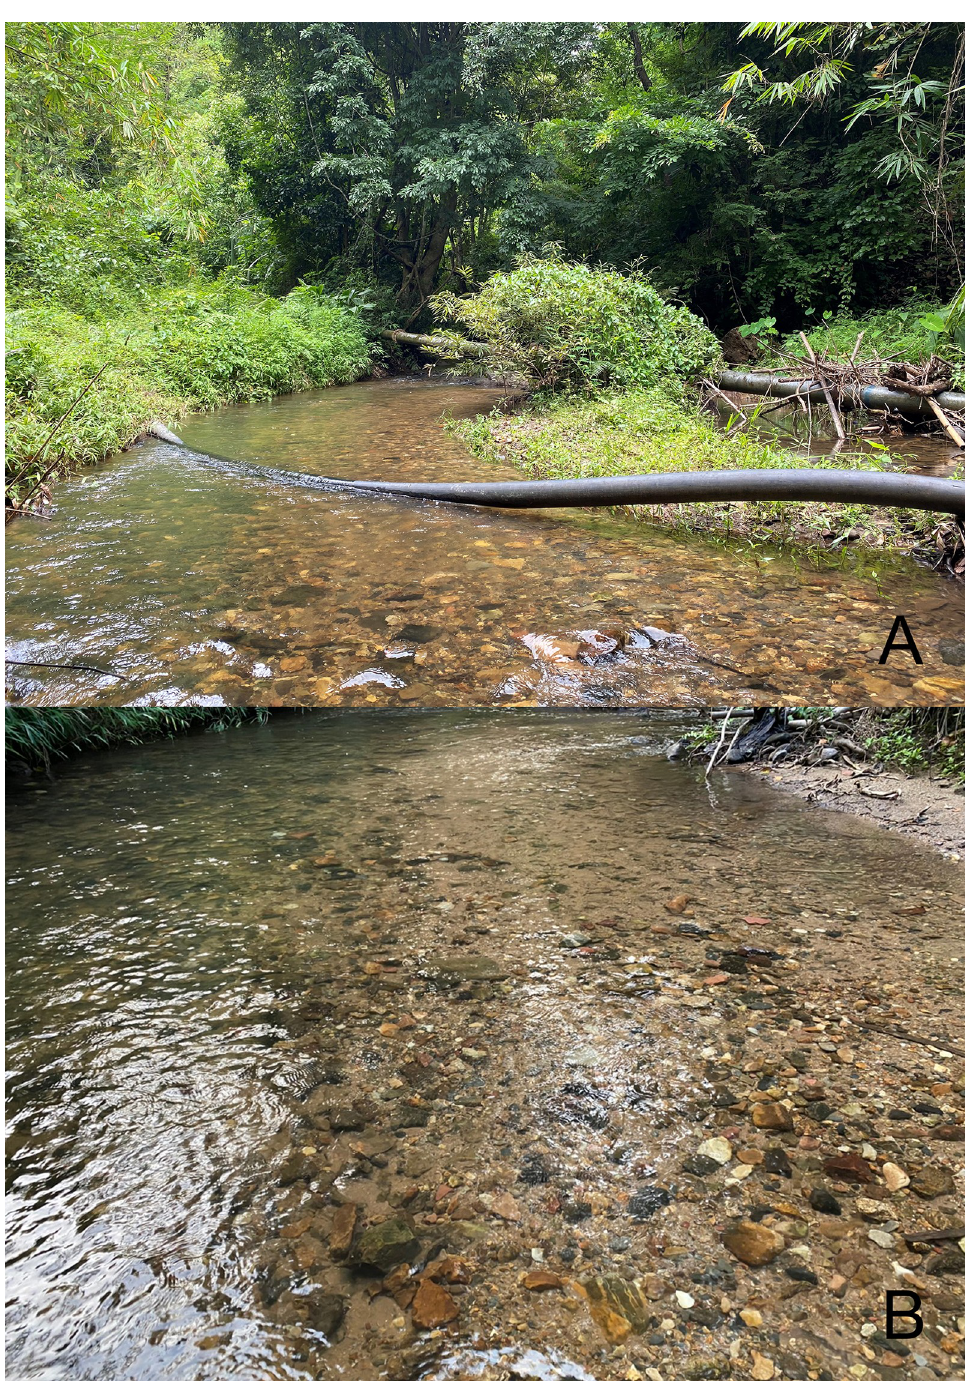
Fig 8. Cymbalcloeon sartorii gen. nov. et sp. nov. Habitat. (A) sampling site, Huai Khayeng stream, Kanchanaburi province, Thailand, (B) microhabitat.